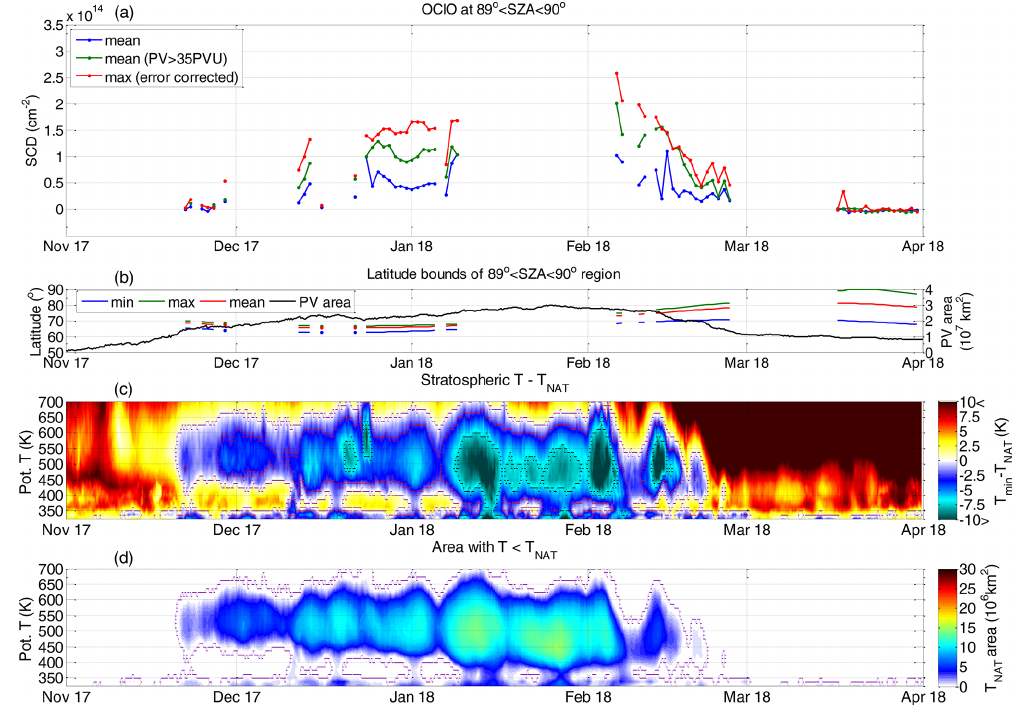
Figure 1. Time series of daily OClO SCDs for the Arctic winter 2017/18 in comparison with the meteorological quantities. Please note that many days of measurements are missing for this winter due to calibration processes after launch. (a) The blue line represents the mean daily OClO SCDs for 89 ◦ < SZA < 90 ◦ , the green line the mean of the measurements within the polar vortex (PV > 35PVU at PT 475K) and the red line the maximum OClO SCDs (for details, see text). (b) Time series of minimum, maximum and mean latitudes of the TROPOMI pixels which contribute to the mean OClO SCDs shown in (a) (left axis). Also shown is the polar vortex size (area where PV > 35PVU at the PT 475K) indicated by a black line (right axis). (c) Time series of temperature evolution in the lower stratosphere represented as a difference between the minimum and NAT condensation temperature ( T NAT ) as a function of altitude (indicated by the potential temperature). Violet, red and black contour lines indicate T NAT , T (cid:48) and the ice freezing temperature T ICE , respectively. (d) Time series of the size of the area NAT where the temperature is below T NAT as a function of the potential temperature. Zero is indicated by the violet contour